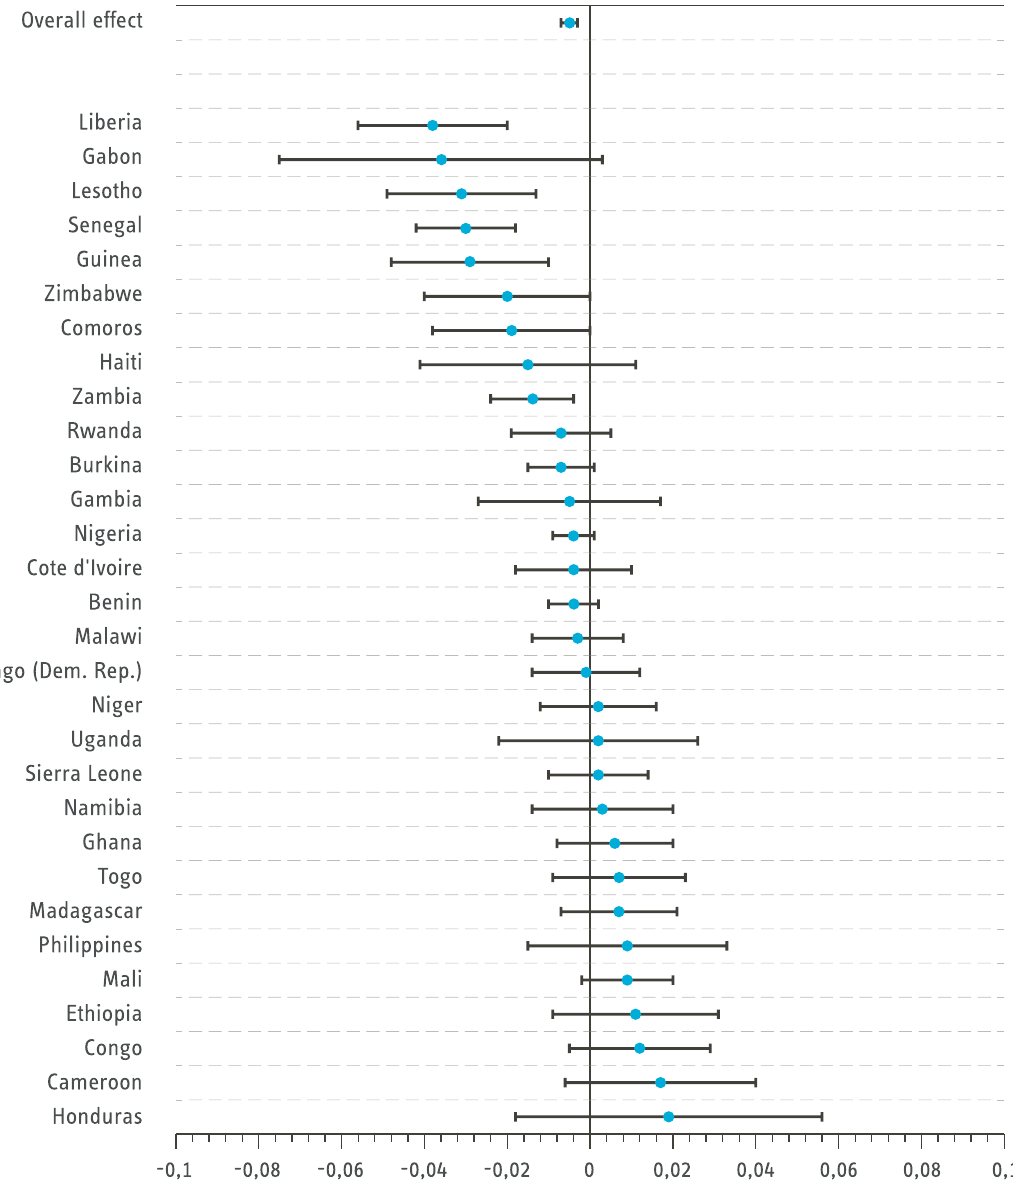
Fig 1. Effect size of outdoor cooking on ARI for children aged 0-4 (Probit estimation with controls). Bars signal 95 percent confidenceintervals. Standarderrors are clusteredon household level. Congorefers to the Republicof Congo and Congo(Dem. Rep) refers to the Democratic Republicof the Congo. Source: DHS all country dataset from 2005-2014.